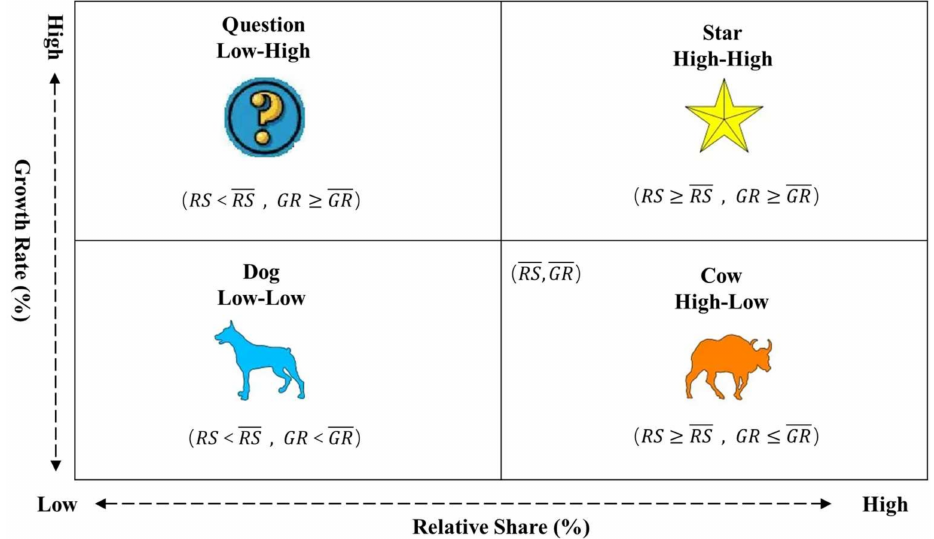
Figure 3. Boston Consulting Group matrix and decoupling